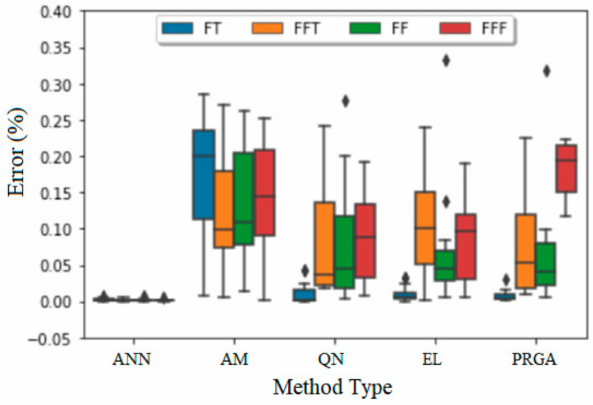
Figure 15. Location errors: simulated cases.